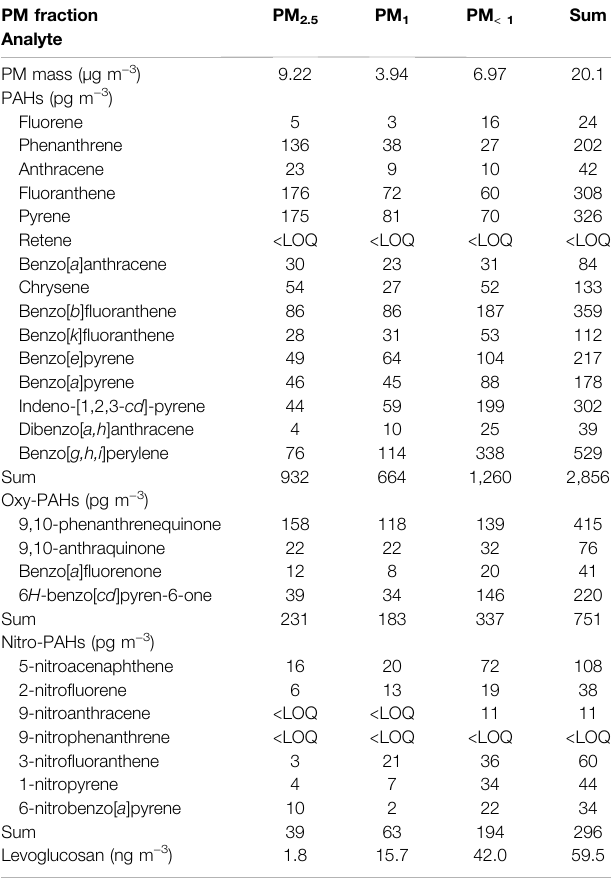
TABLE 5 | PM mass (μg m − 3 ), concentrations of PAHs, oxy-PAHs, nitro-PAHs (pg m − 3 ), and levoglucosan (ng m − 3 ) in the fractionated PM sample. PM fraction PM